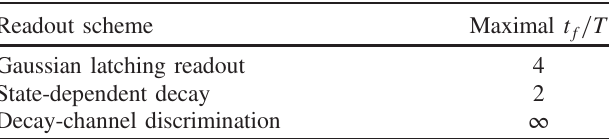
TABLE I. Summary of the maximal speedups for the three readout schemes discussed in this